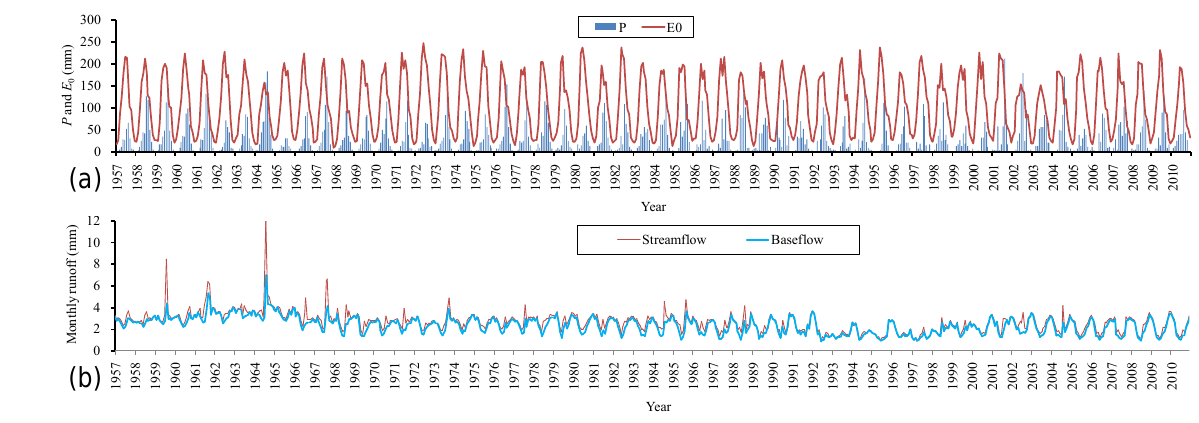
Figure 2. The monthly meteorological data (a) and streamflow–baseflow data (b) from 1957 to 2010 in catchment C1.